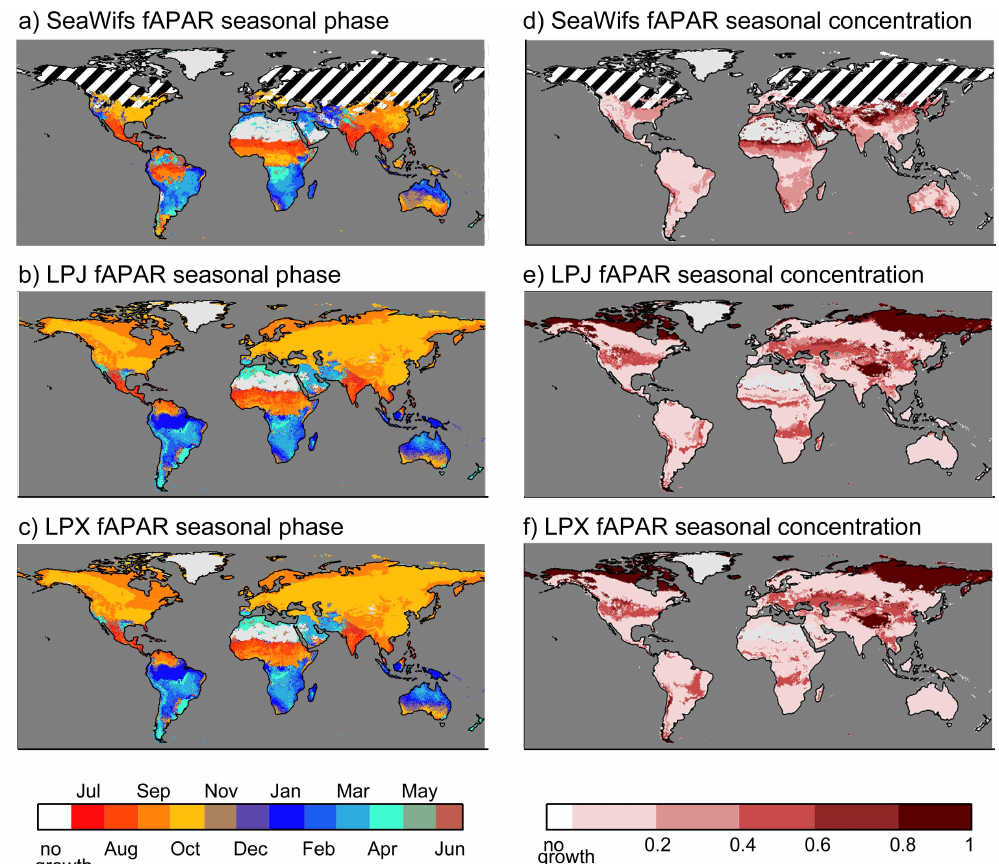
Fig. 4. Comparison of observed and simulated seasonal phase and seasonal concentration of fraction of absorbed photosynthetically active radiation (fAPAR) averaged over the period 1998–2005 from (a) seasonal phase from SeaWiFS (Gobron et al., 2006) and as simulated by (b) LPJ and (c) LPX; seasonal concentration from (d) SeaWiFS, (e) LPJ and (f) LPX. Hashed area in (a) and (d) shows areas where no comparison is